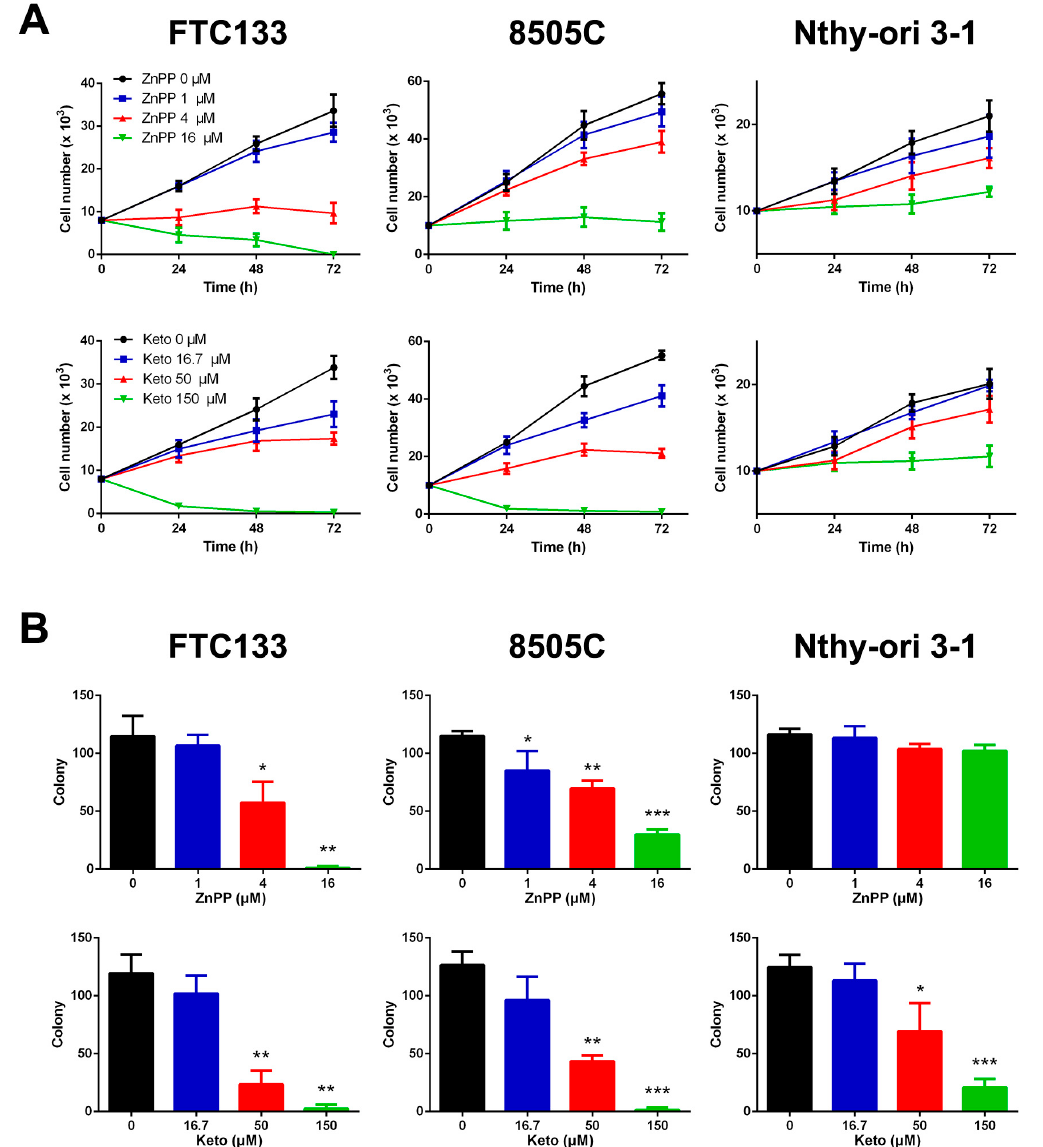
Figure 1. Decreased cell viability ( A ) and clonogenic ability ( B ) following treatment with heme oxygenase-1 inhibitors, zinc protoporphyrin-IX (ZnPP) and ketoconazole (Keto), in thyroid cancer cell lines (FTC-133 and 8505C) and a normal thyroid cell line (Nthy-ori 3-1). * p < 0.05 versus control, ** p < 0.01, *** p < 0.001.